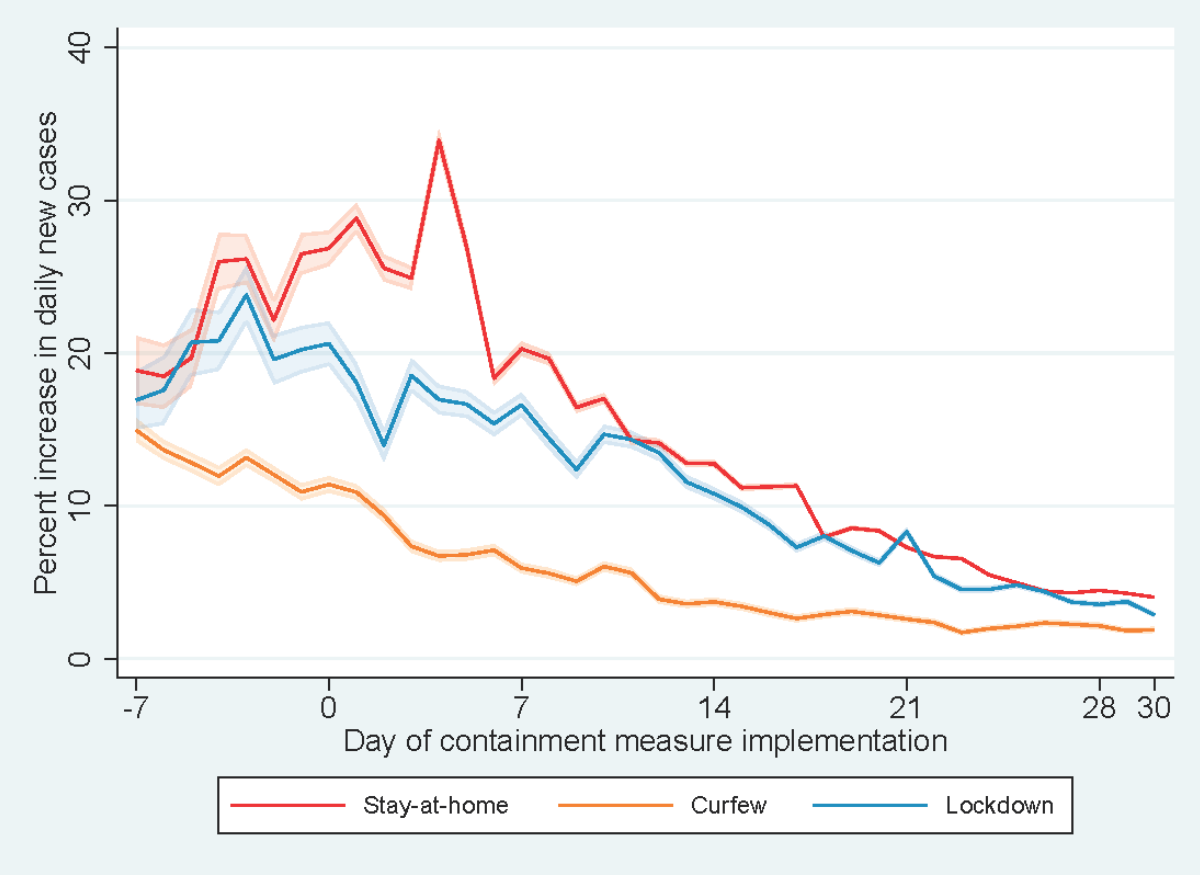
Figure 1. Percent increase in daily new cases vs days since containment measure by type of containment